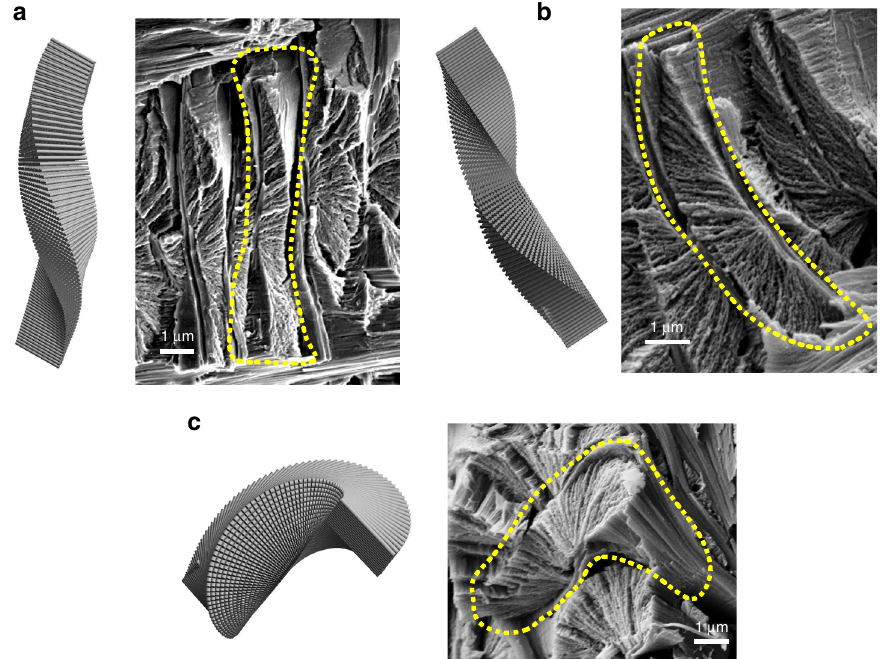
Fig. 6 Comparison between the model and its biological counterpart. a Longitudinal cross-section. b Transversal cross-section. c Longitudinal cross- section, oblique